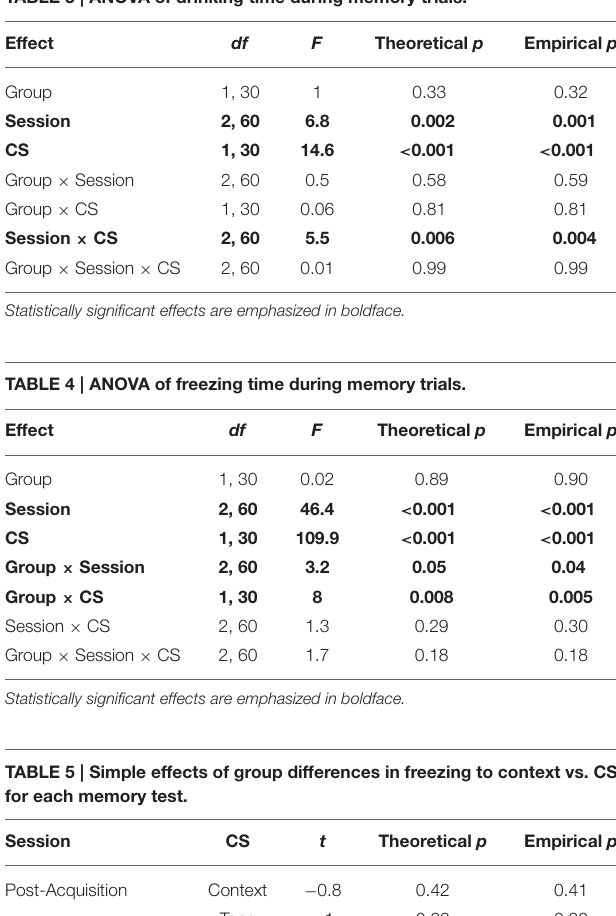
TABLE 3 | ANOVA of drinking time during memory trials.